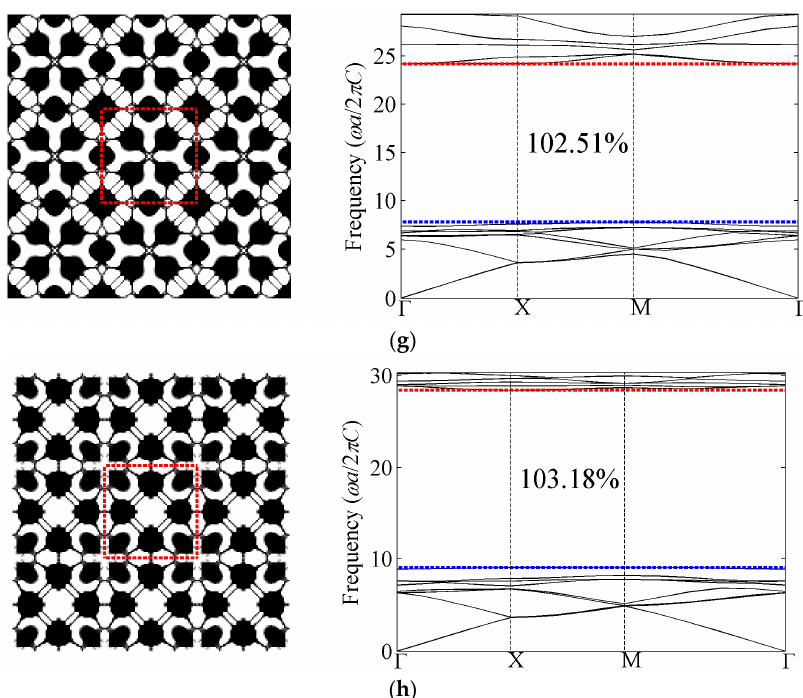
Figure 7. Optimized topologies and corresponding band structures for out ‐ of ‐ plane mode with bulk modulus constraint. The black and white colors represent silicon and air, respectively. ( a ) The first band gap; ( b ) the second band gap; ( c ) the third band gap; ( d ) the fourth band gap; ( e ) the fifth band gap; ( f ) the sixth band gap; ( g ) the seventh band gap; and ( h ) the eighth band gap.